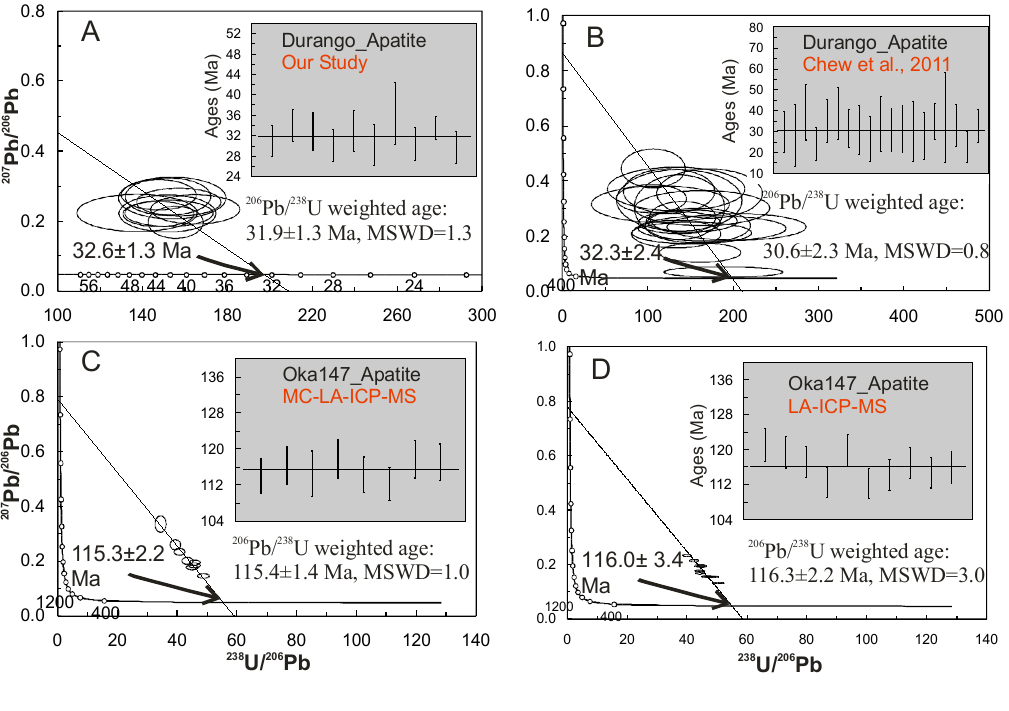
Figure 3. U-Pb isotopic ages for apatite secondary standards and sample. The U-Pb age of the secondary standard—Durango apatite is shown ( A ), and it is identical to the reported value ( B ) by Chew et al. [41]. Apatite from carbonatite Oka147 was dated by the laser ablation multi-collector inductively coupled plasma mass spectrometry (LA-MC-ICP-MS) ( C ) and LA-ICP-MS ( D